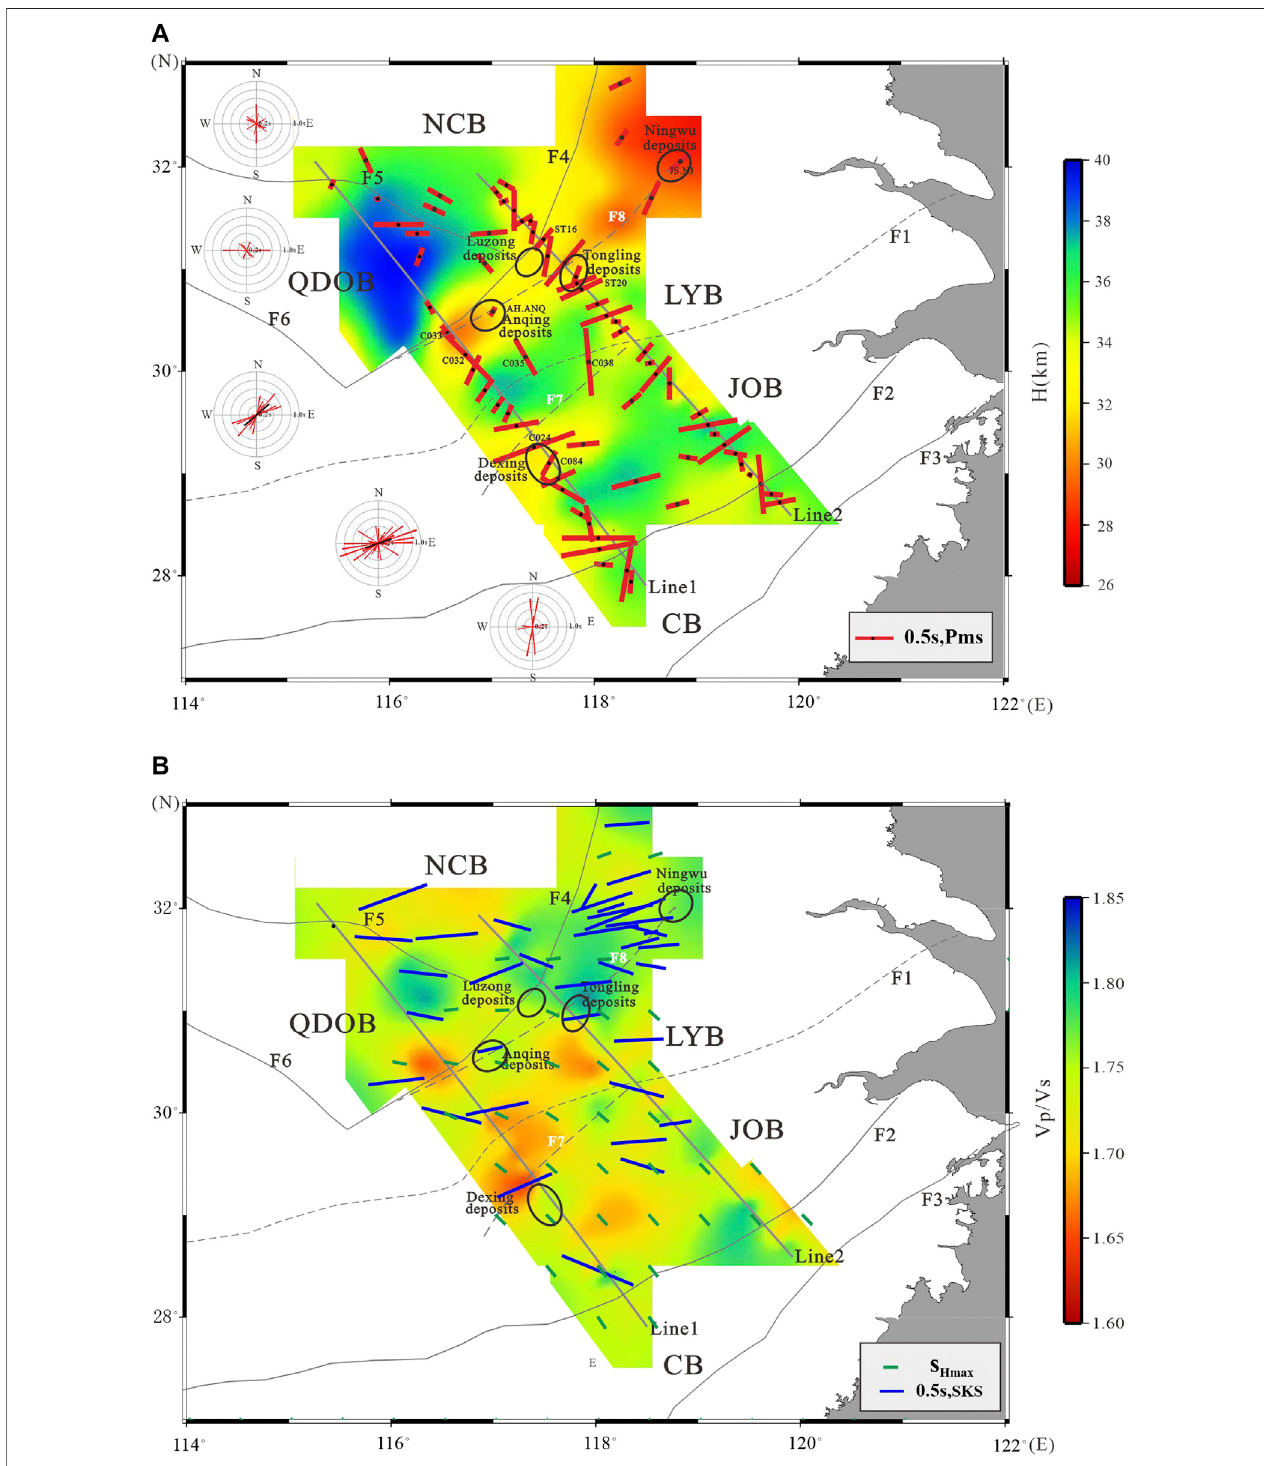
FIGURE 6 | Distribution of crustal thickness (A) : the length of the bars denotes the delay time, the azimuths of the bars indicates the fast wave directions, and the rose mapsisshown inthecorresponding geologicalunit, thered andblack barsrepresenttheanisotropy parametersofeach station andaveragevaluesoftheLYBand JOB,respectively.Theintervalbetweeneachringandfromthecentertotheoutermostringis2and1 s,respectively.DistributionsofVp/Vs (B) :thebluebarsindicatethe average splitting parameter of the SKS (Yang et al., 2019), and the green bars indicate the maximum horizontal stress (S Hmax ) orientations (Heidbach et al., 2018). The black circle indicates the metallogenic area. Labels are the same as Figure 1 .